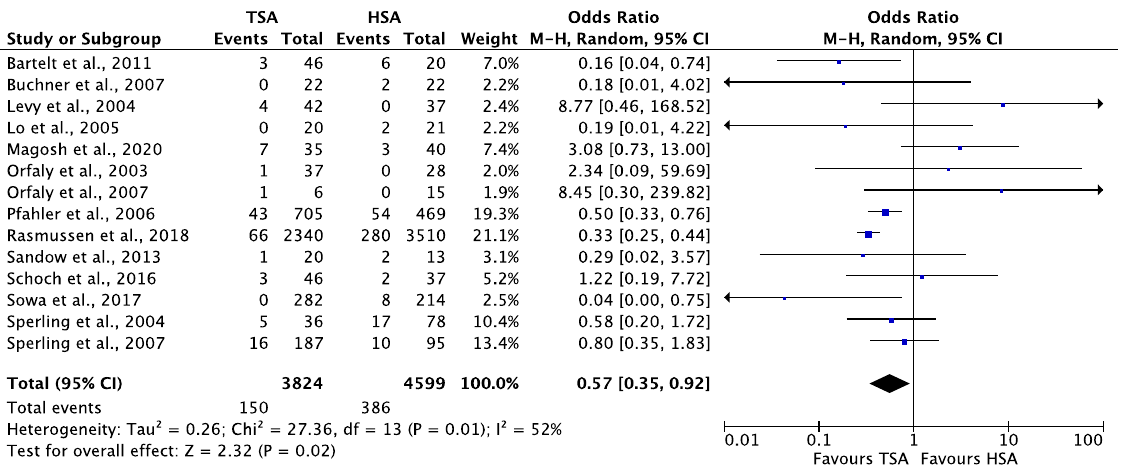
Figure 4. Meta-analysis of the comparison: Revision rate.